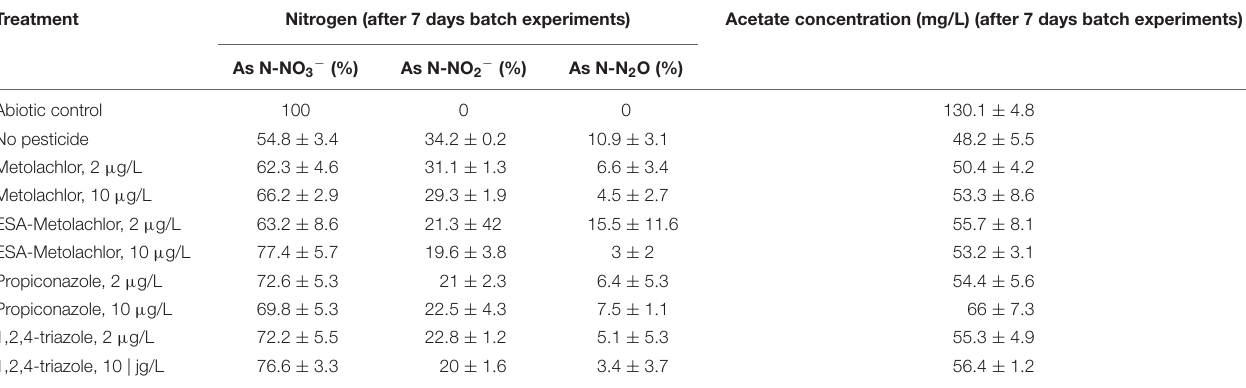
TABLE 2 | Nitrogen balance and transformation and acetate concentration during denitrification experiments (batch, n = 3) in the presence or absence of pesticides or metabolites (at 2 or 10 µ g/L) (here after 7 days of incubation). Treatment Nitrogen (after 7 days batch experiments) Acetate concentration (mg/L) (after 7 days batch